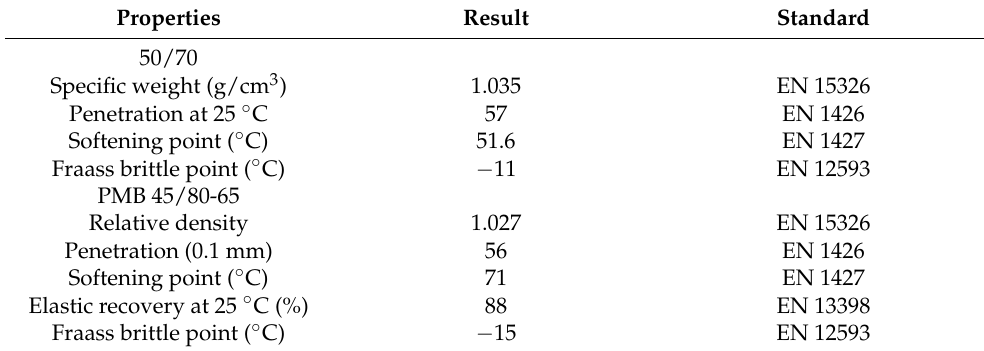
Table 2. Properties of